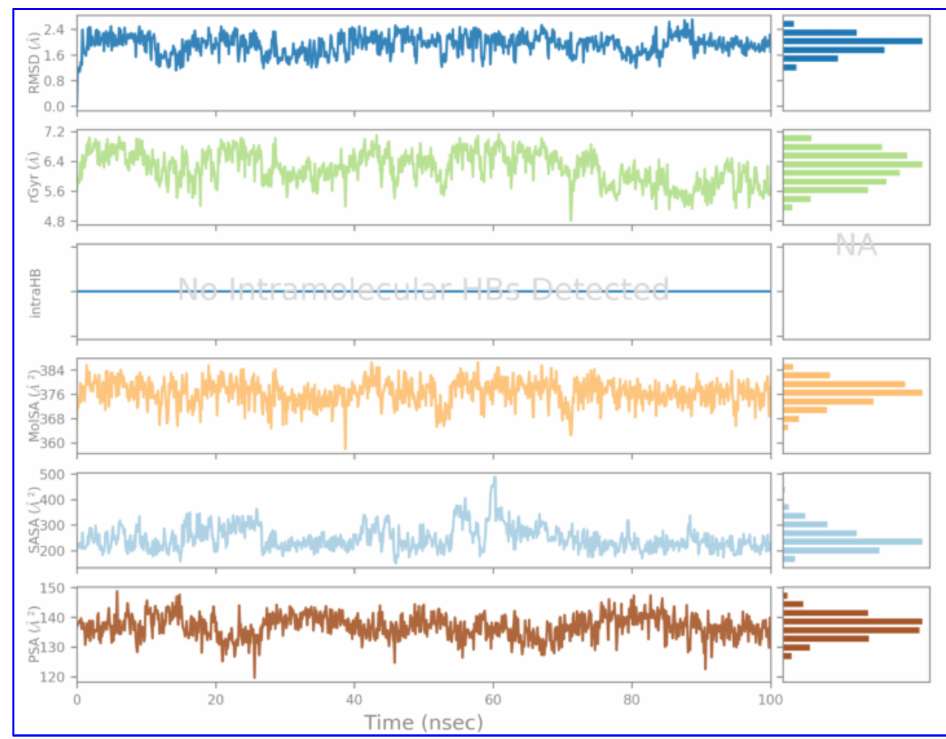
Figure 9. Ligand properties—Root mean square deviation (RMSD) of the ligand with respect to the reference conformation; rGyr (Measure of Extendedness of ligand); intraHB; MolSA; SASA; PSA.2.5. In-vitro Validation of Lead Compound.